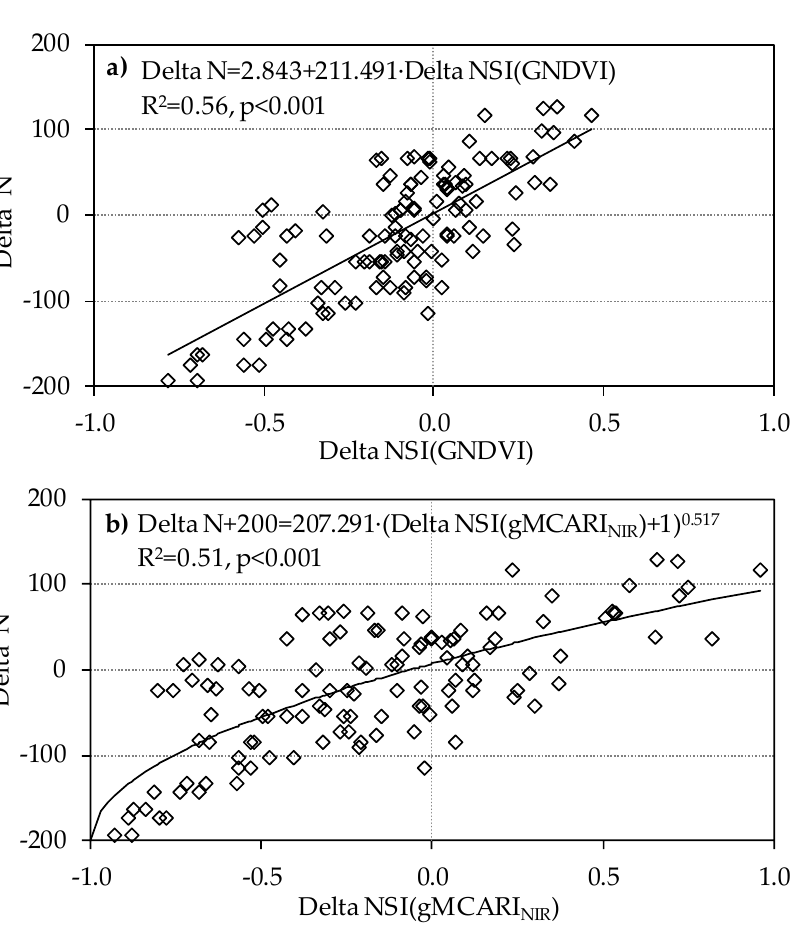
Figure 4. Relationship between Delta N (N increased or decreased compared with the optimum treatment) and Delta NSI(GNDVI) ( a ) or Delta NSI(gMCARI NIR ) ( b ) (R_GNDVI-1 or R_gMCARI NIR -1) (pooled data of the two years, 75% data).